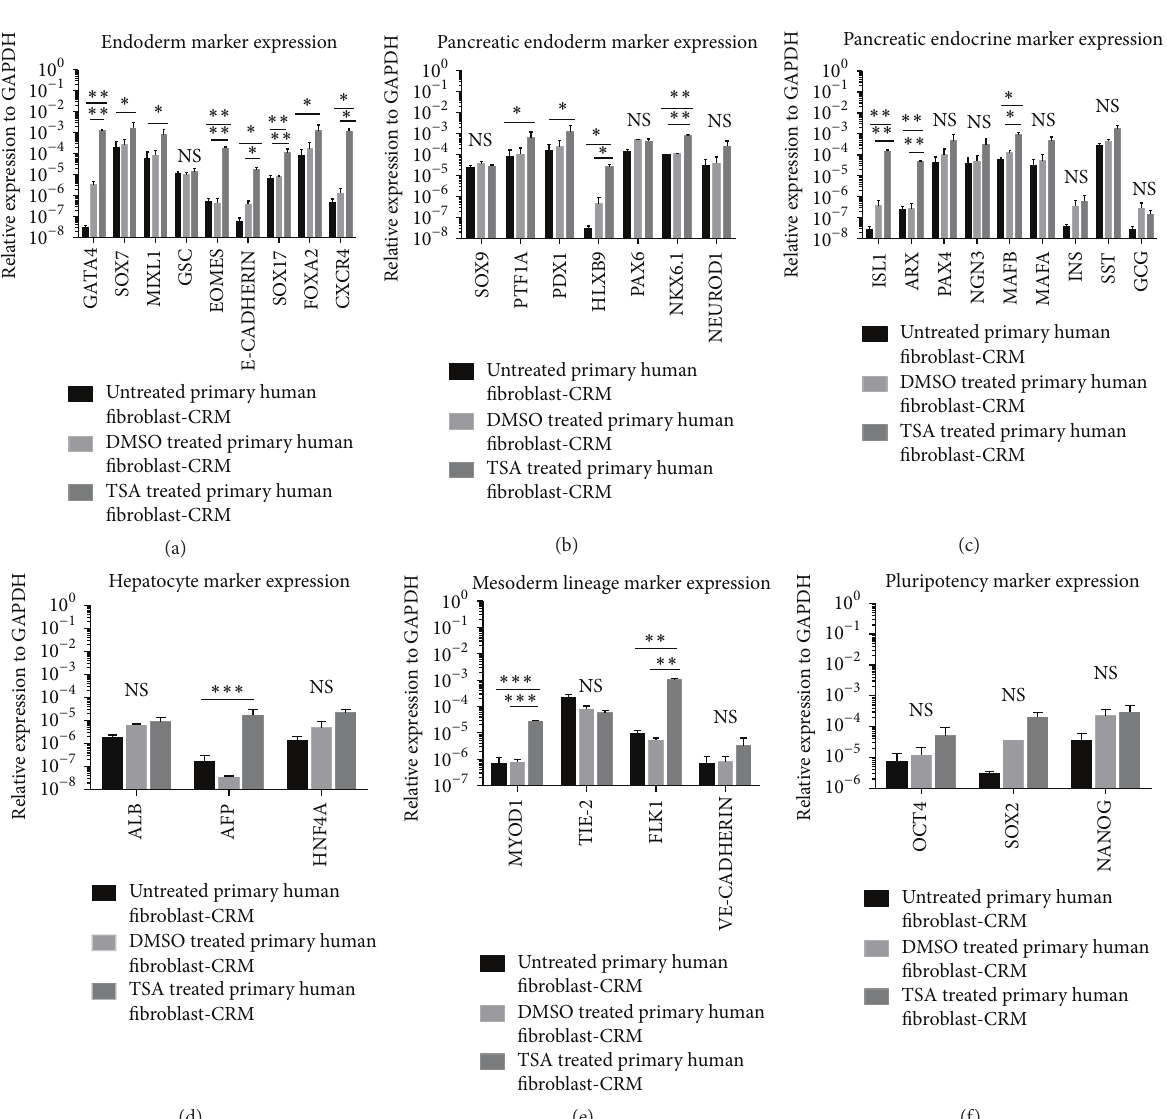
and VE-CADHERIN (Figure 1(e) and Figure S1E). Pluripo- tency marker genes OCT4, SOX2 , and NANOG (Figure 1(f) and Figure S1F) were not induced. When the remodeling medium was removed, expression of the pancreatic endoder- mal genes was not